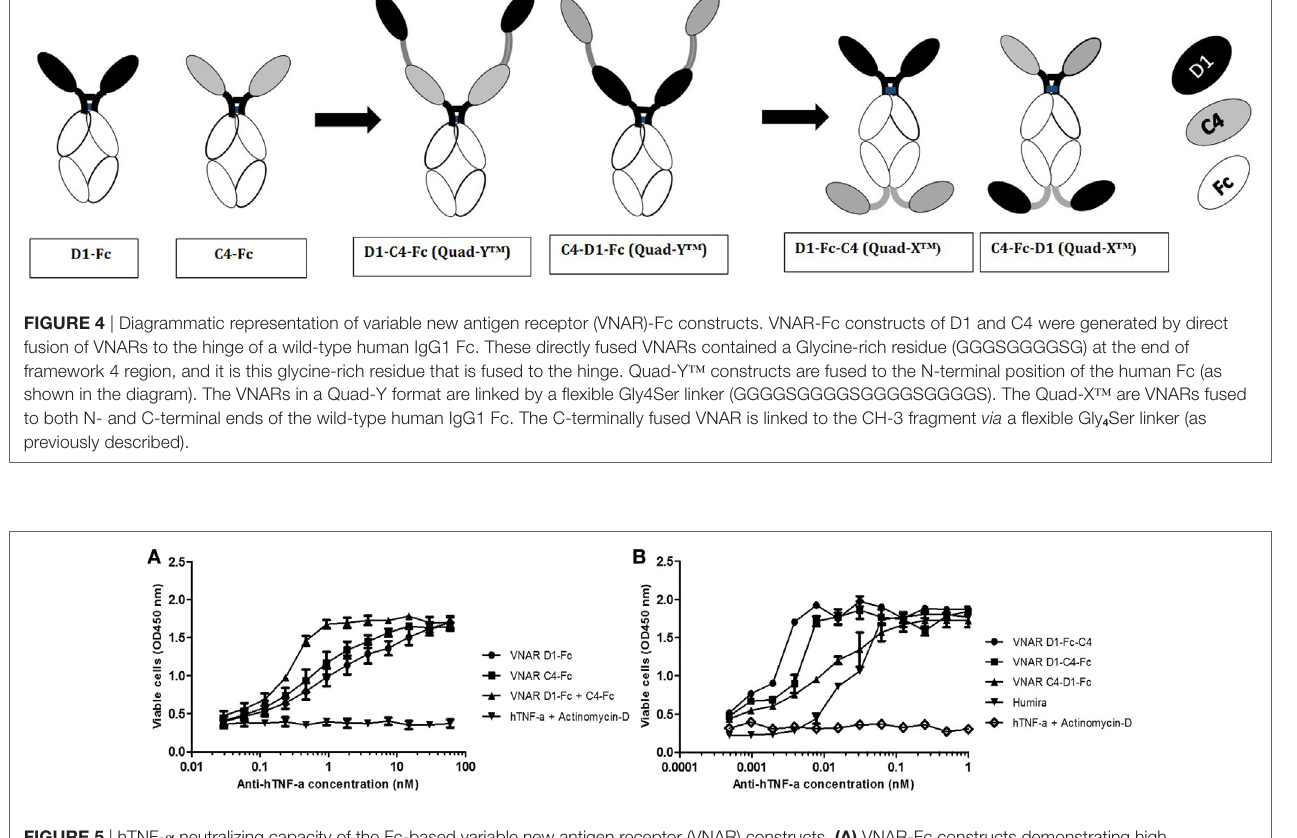
TaBle 3 | Binding ELISA of variable new antigen receptor (VNAR) constructs post 28 days incubation at pH 3.